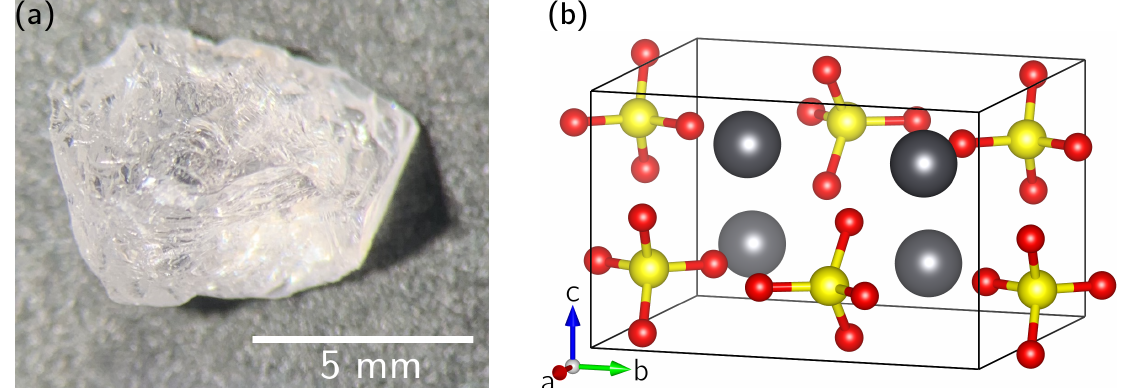
Figure 1. Left: Single crystal of anglesite, PbSO 4 , from location, Country (mineralogical state collection Figure 1. ( a ) Single crystal of anglesite, PbSO 4 , from Monteponi Mine, Iglesias, Sardinia/Italy inventory no. XXXXX). Right: Unit cell of anglesite viewed along the standard orientation of the crystal (Mineralogical State Collection, Munich inventory MSM 6140). ( b ) Unit cell of anglesite according shape, see also Table. The lead atoms (grey) at Wyckoff position 4 c , related by a glide plane in ac and a to Reference [20]. The lead atoms (gray, located at W YCKOFF position 4 c ) are related by glides ( a 1 ( a 3 c ) and ( 1 bc ) , ( 3 bc ) , and are co-ordinated by the ten nearest oxygen atoms (red). The sulfur atoms glide plane in bc , are coordinated by ten nearest oxygen atoms (red). The sulfur atoms (yellow) are located 4 4 4 ) and ( ab 3 ) planes, with their covalent bonds to oxygen in tetrahedral (yellow) are located in the ( ab 1 in the ab plane, with their covalent bonds to oxygen in tetrahedral coordination also shown. a Drawing 4 4 co-ordination also shown. (Drawing generated with the V ESTA program generated with the Vesta program [26].